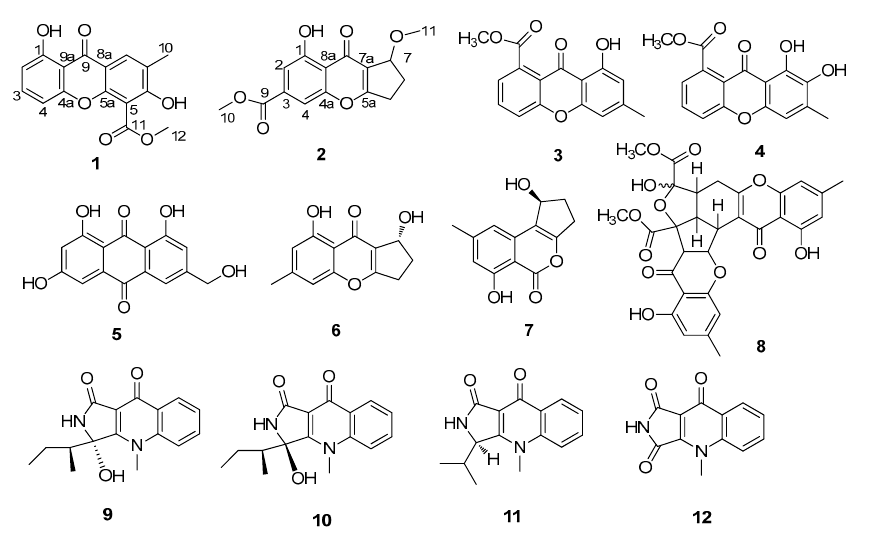
Figure 1. Structures of metabolites 1 – 12 .